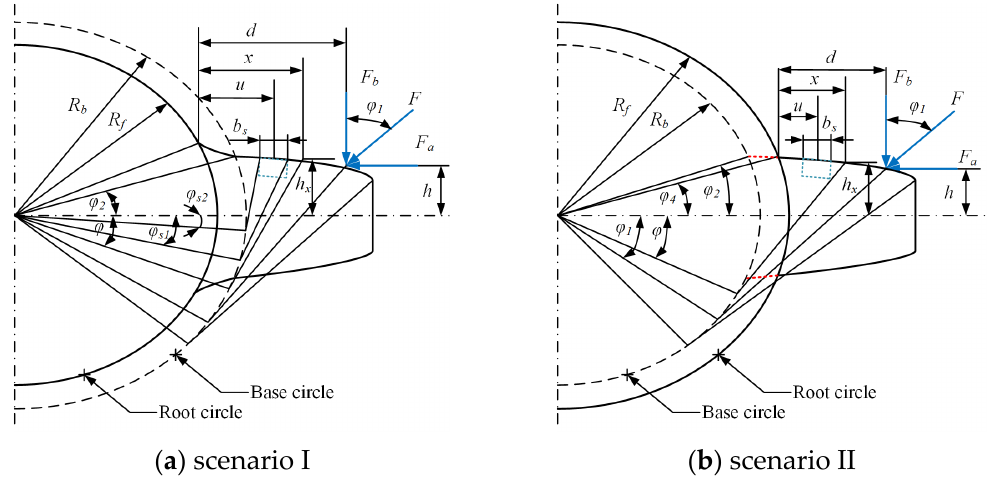
Figure 3. Geometric tooth model of spalling spur gear.